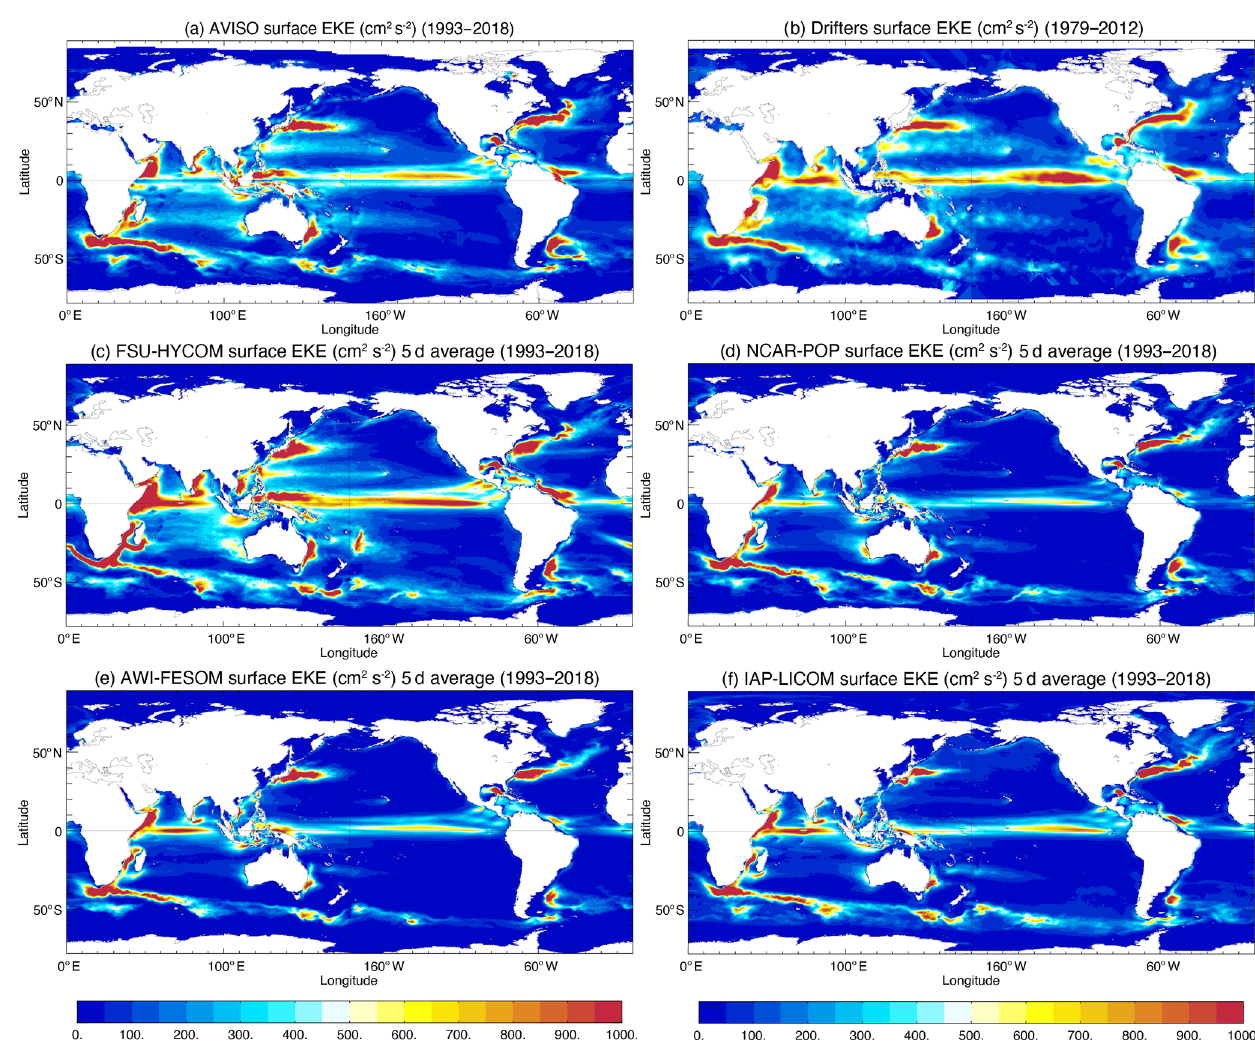
Figure 18. Surface EKE from (a) AVISO and (b) drifter observations. Modeled surface EKE calculated from 5d average fields for the high-resolution (c) FSU-HYCOM, (d) NCAR-POP, (e) AWI-FESOM, and (f)